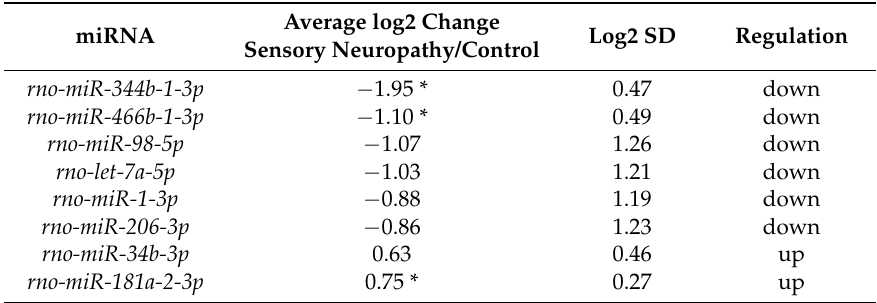
Table 3. Expression of selected microRNAs (miRNAs) by microarray analysis. Average log2 Change Log2 SD Regulation miRNA Sensory Neuropathy/Control rno-miR-344b-1-3p − 1.95 * 0.47 down rno-miR-466b-1-3p − 1.10 * 0.49 down − 1.07 1.26 down rno-let-7a-5p − 1.03 1.21 1.19